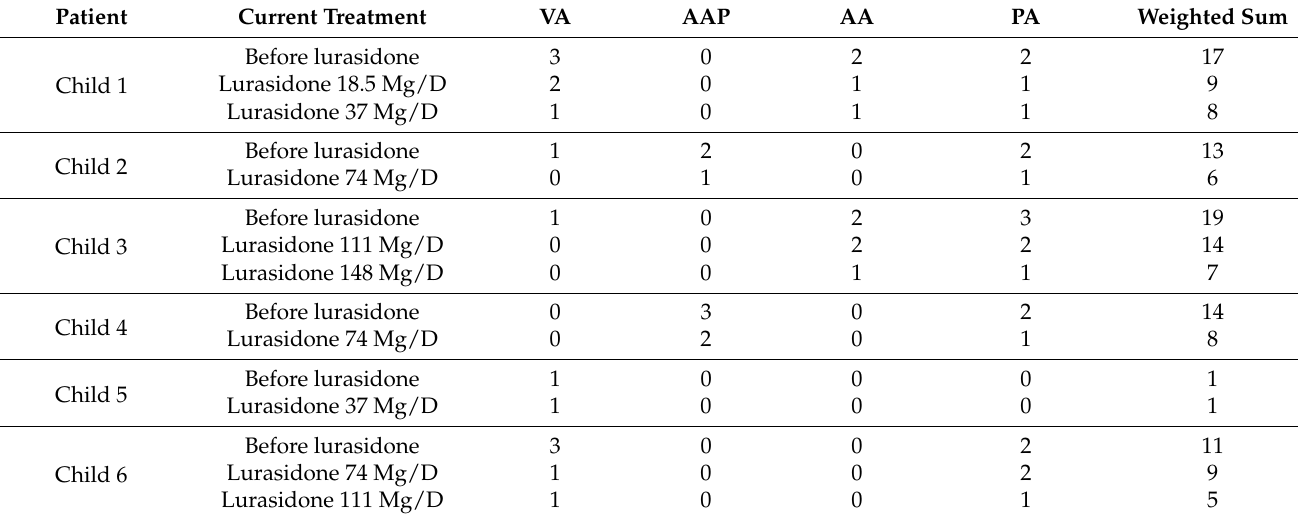
Table 3. The Modified Overt Aggression Scale